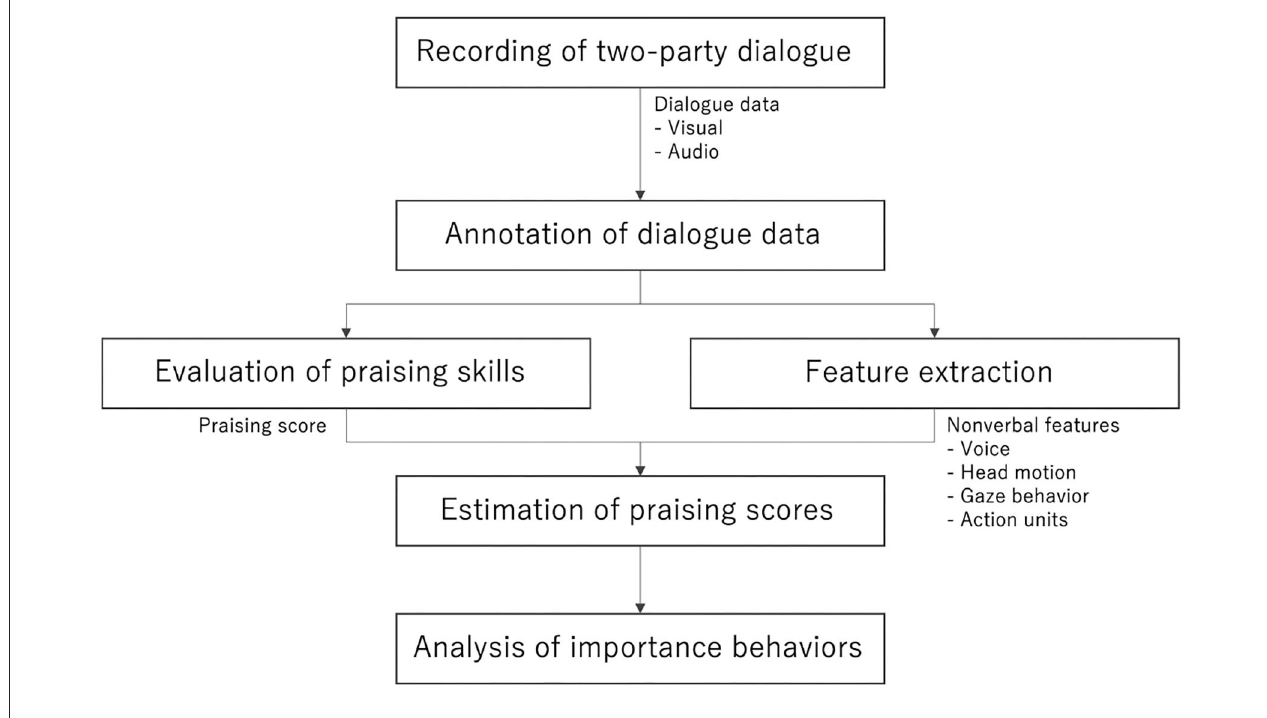
FIGURE 1 | Overall pipeline of our approach.